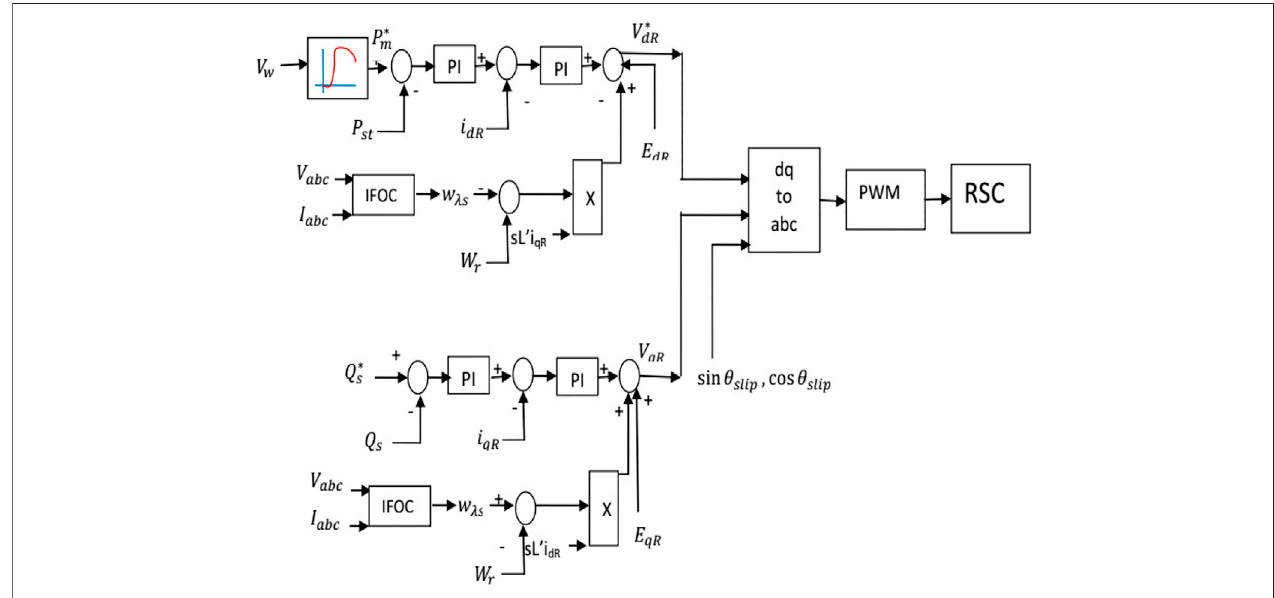
FIGURE 3 | Complete RSC controller design using the IFOC